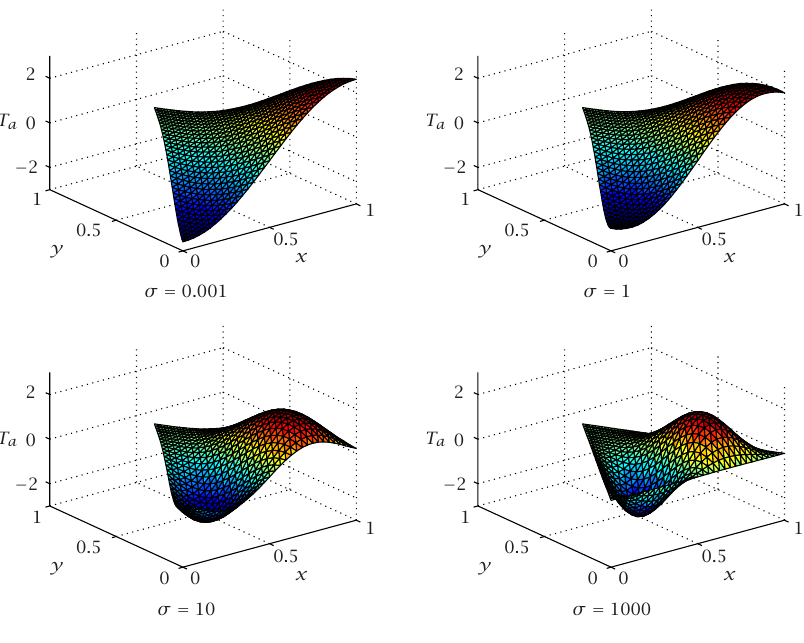
Figure 6.1 . The ( 0 , 1 ) antisymmetric